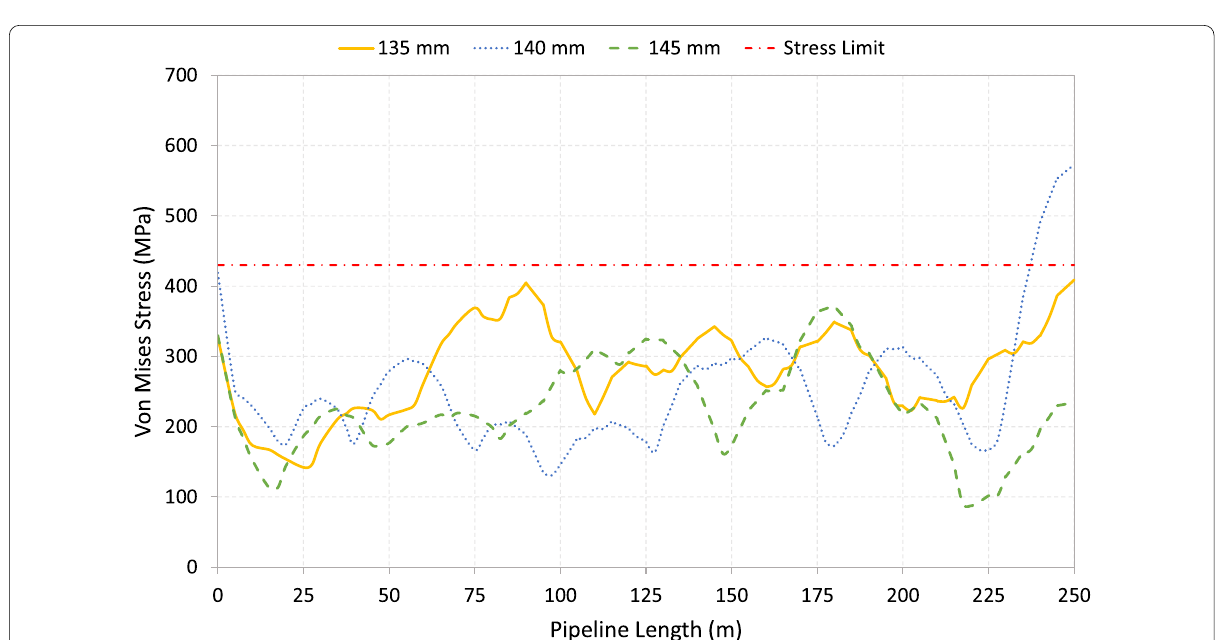
Fig. 4 Envelopes of the von Mises stresses of the pipeline for concrete thickness range 135–145 mm (1-year RPV wave